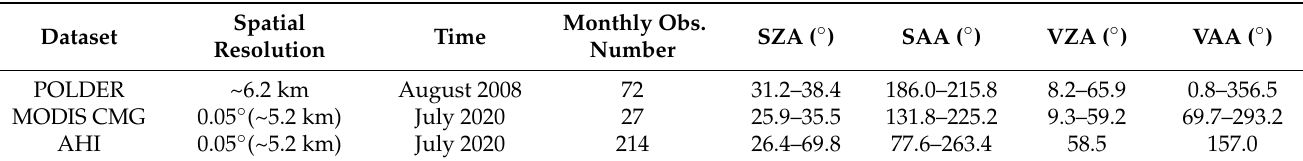
Table 4. Information on multiangle data compared with POLDER and MODIS at a typical vegetation